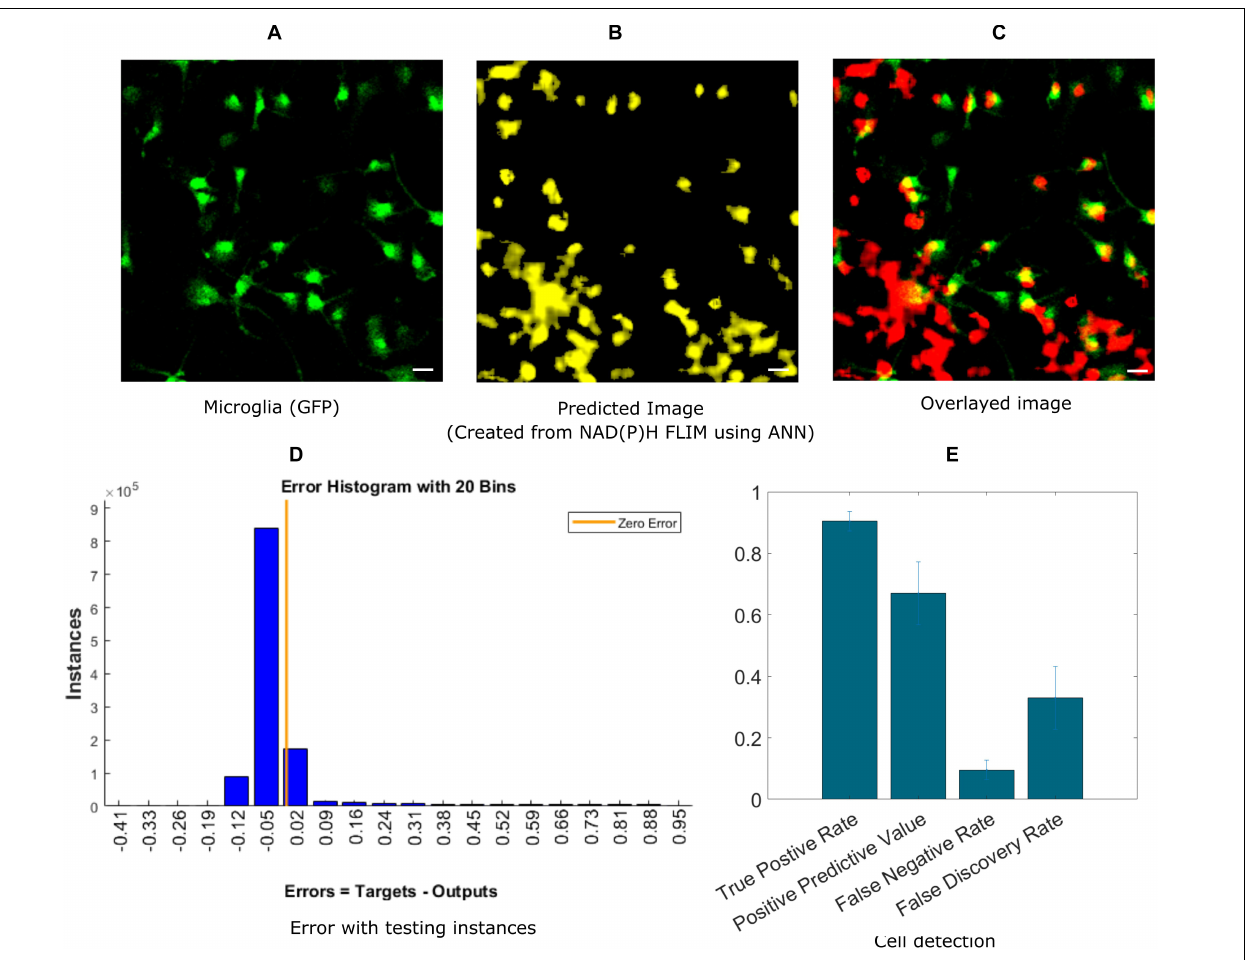
FIGURE 2 | Prediction of microglia from NAD(P)H lifetime data in mixed glial cell cultures where microglia cells are GFP-labeled. In this approach, ANN is applied on exported lifetime parameters of the endogenous fluorophore NAD(P)H. (A) Original fluorescence intensity image of microglia created from the GFP channel (B) Predicted microglia image from NAD(P)H lifetime data from the same field-of-view. (C) Composite image of predicted microglia image and original intensity image. Most of the microglia are accurately predicted as seen from the composite image. But there are a few microglia not detected and some false positive in the lower left corner (D) Error rate from testing instances, created from the testing microglia dataset (E) TPR, PPV, FNV and FDR from five different dishes (Scale bar 20 µ m, A–C,E